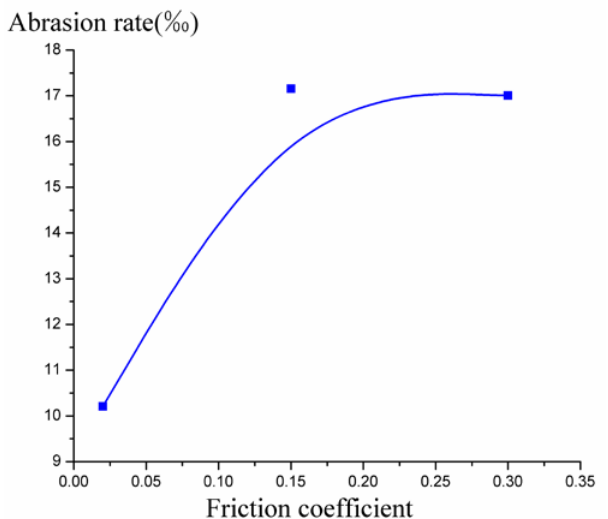
Figure 8: Variation of friction coefficient on the abrasion property of hydraulic hammer with horizontal oriented